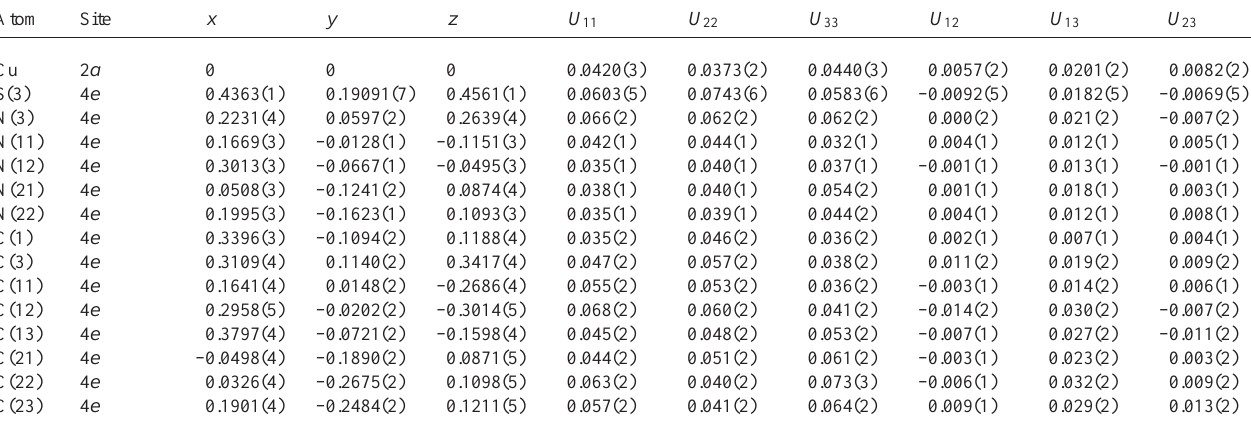
Table 3. Atomic coordinates and displacement parameters (in Å 2 )